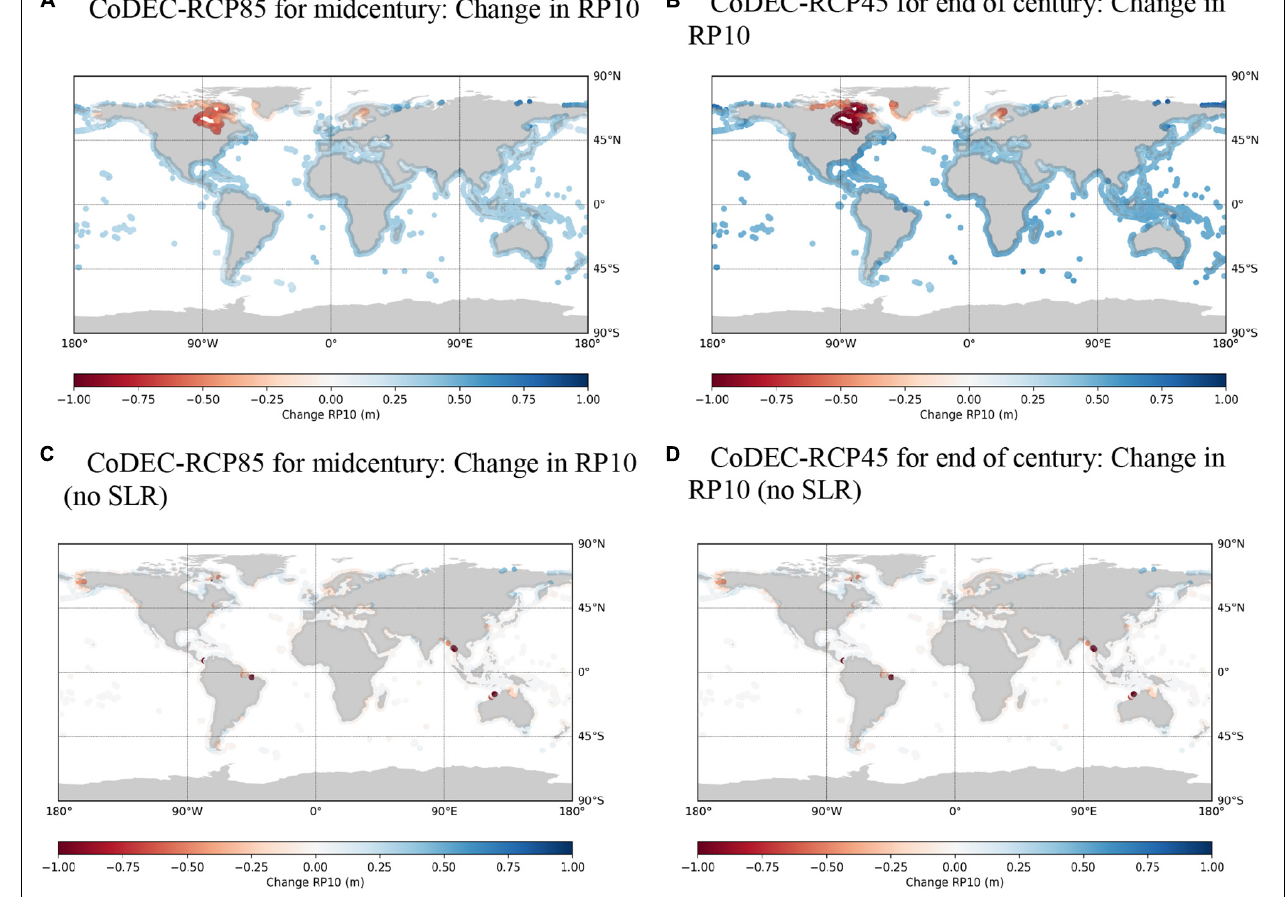
FIGURE 7 | Changes in the 1 in 10-year water levels (RP10) for (A) mid-century (2041–2070 with SLR of 2055) based on CoDEC-RCP8.5 compared to CoDEC-HIST and for (B) the end of the century (2071–2100 with SLR of 2085) based on CoDEC-RCP4.5 compared to CoDEC-HIST. We also show the change when SLR is not taken into account (C,D) . Note the different color